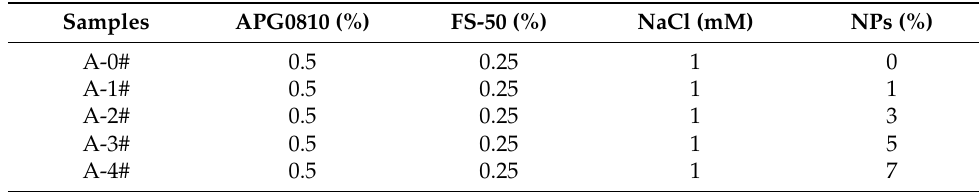
Table 1. Foam dispersions with various compositions.